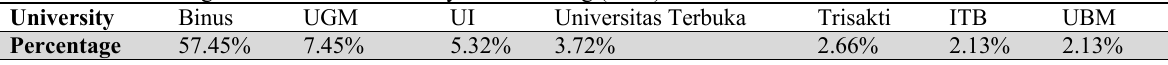
Binus Online Learning Brand Awareness Survey in Palembang